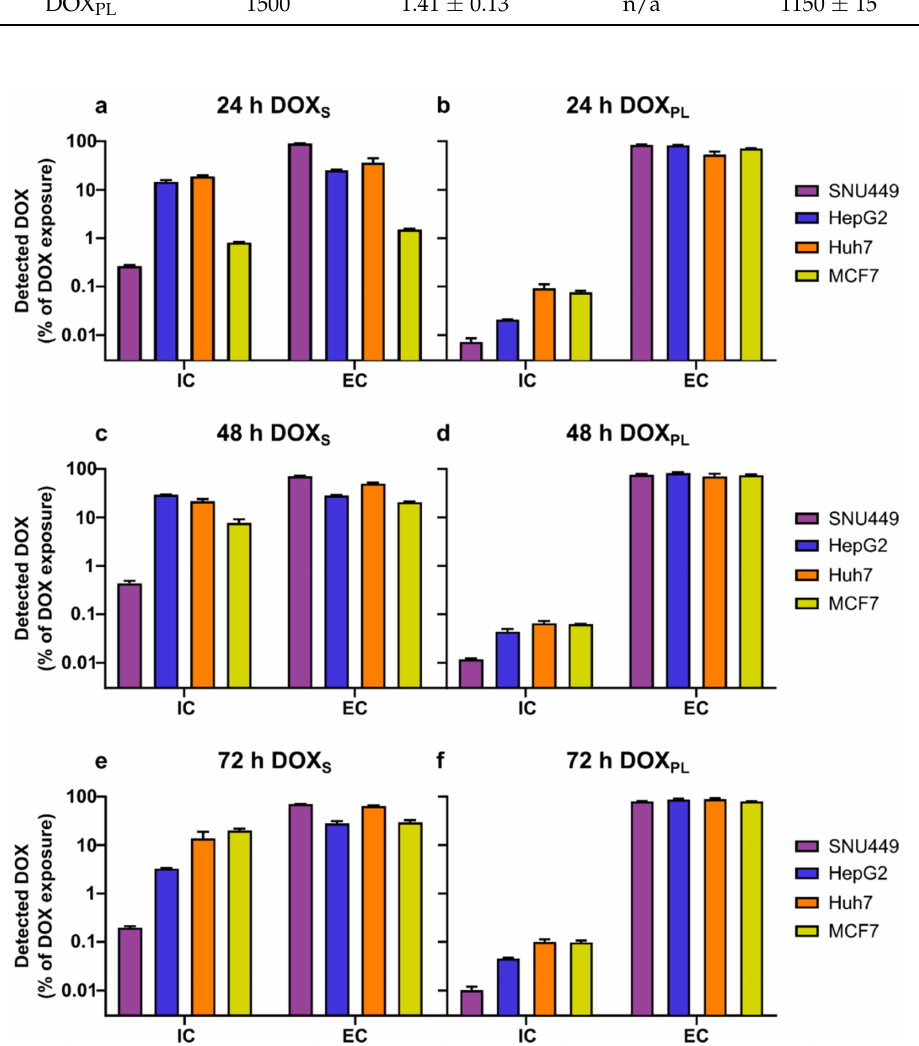
Figure 3. The mean ( ± SD) amount of DOX quantified inside (intracellular, IC) and outside (extracellular, EC) the cells, as a percentage of total added dose of DOX. ( a , c , e ) Cells treated with DOX S ; ( b , d , f ) cells treated with DOX PL . The exposure concentration was based on the calculated IC 50 of that treatment determined in this study, with a maximum concentration of 200 µ